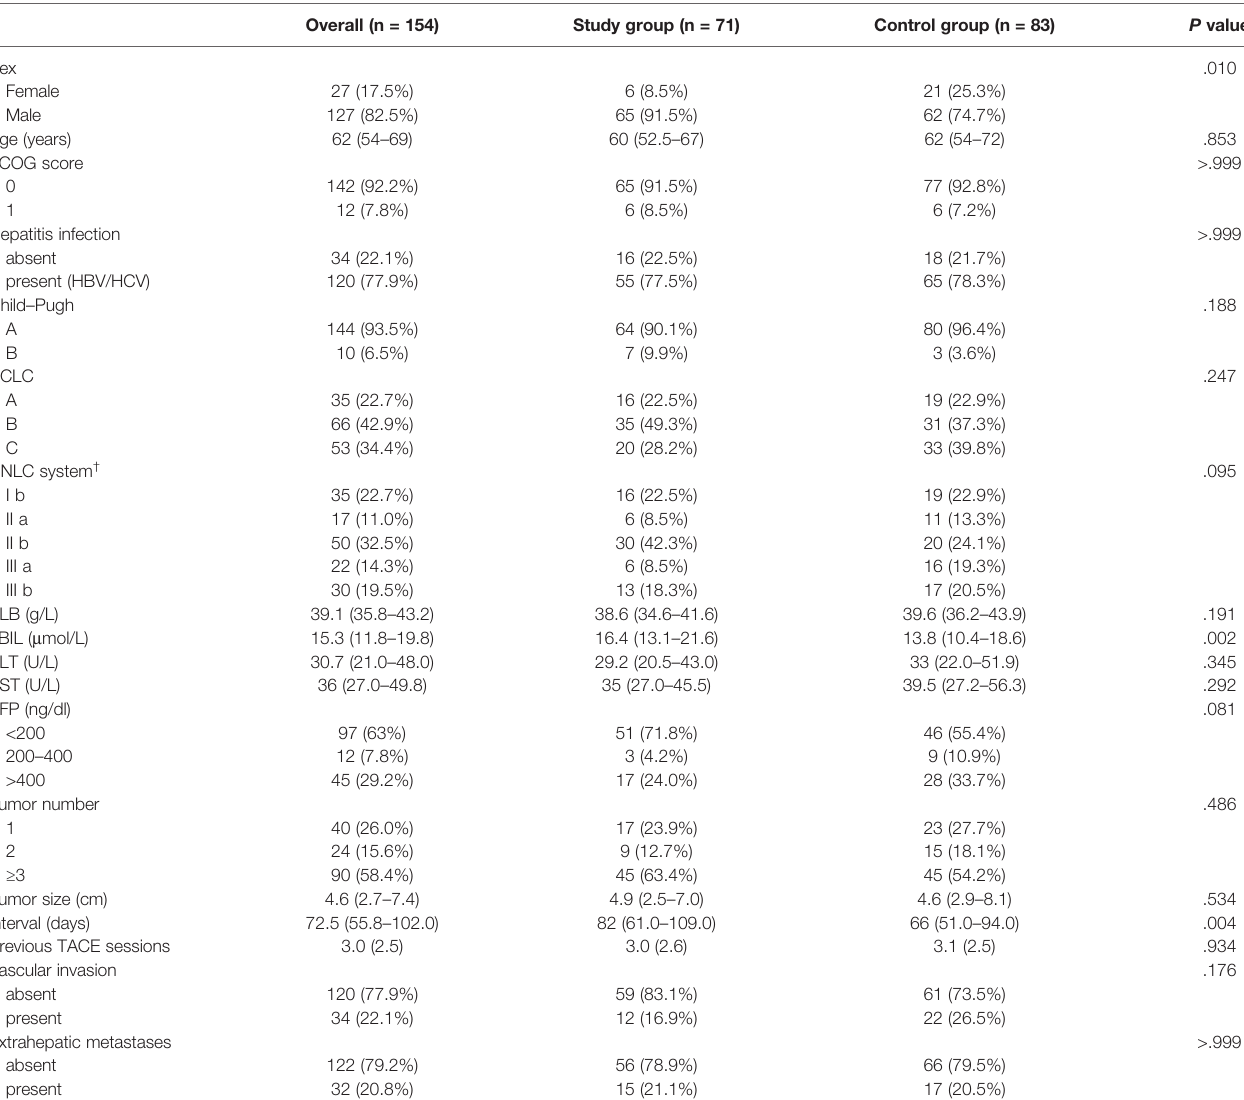
TABLE 1 | Patient characteristics of the two